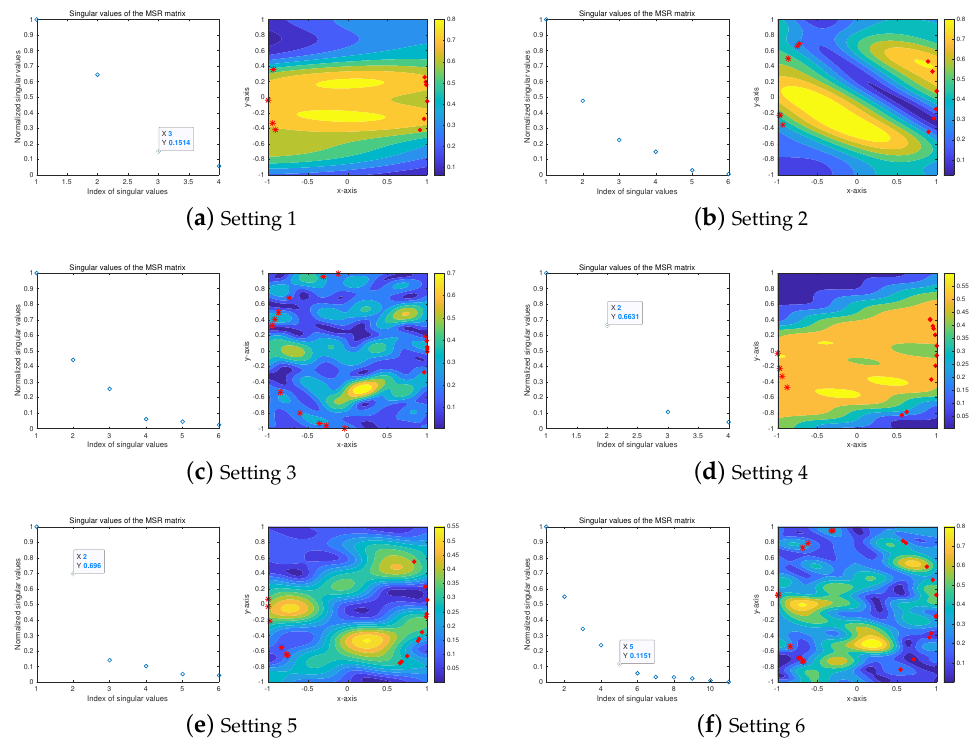
Figure 7. (Example 3) maps of F µ ( r ) . The red-colored marks ◦ and ∗ denote the incident and observation directions, respectively.